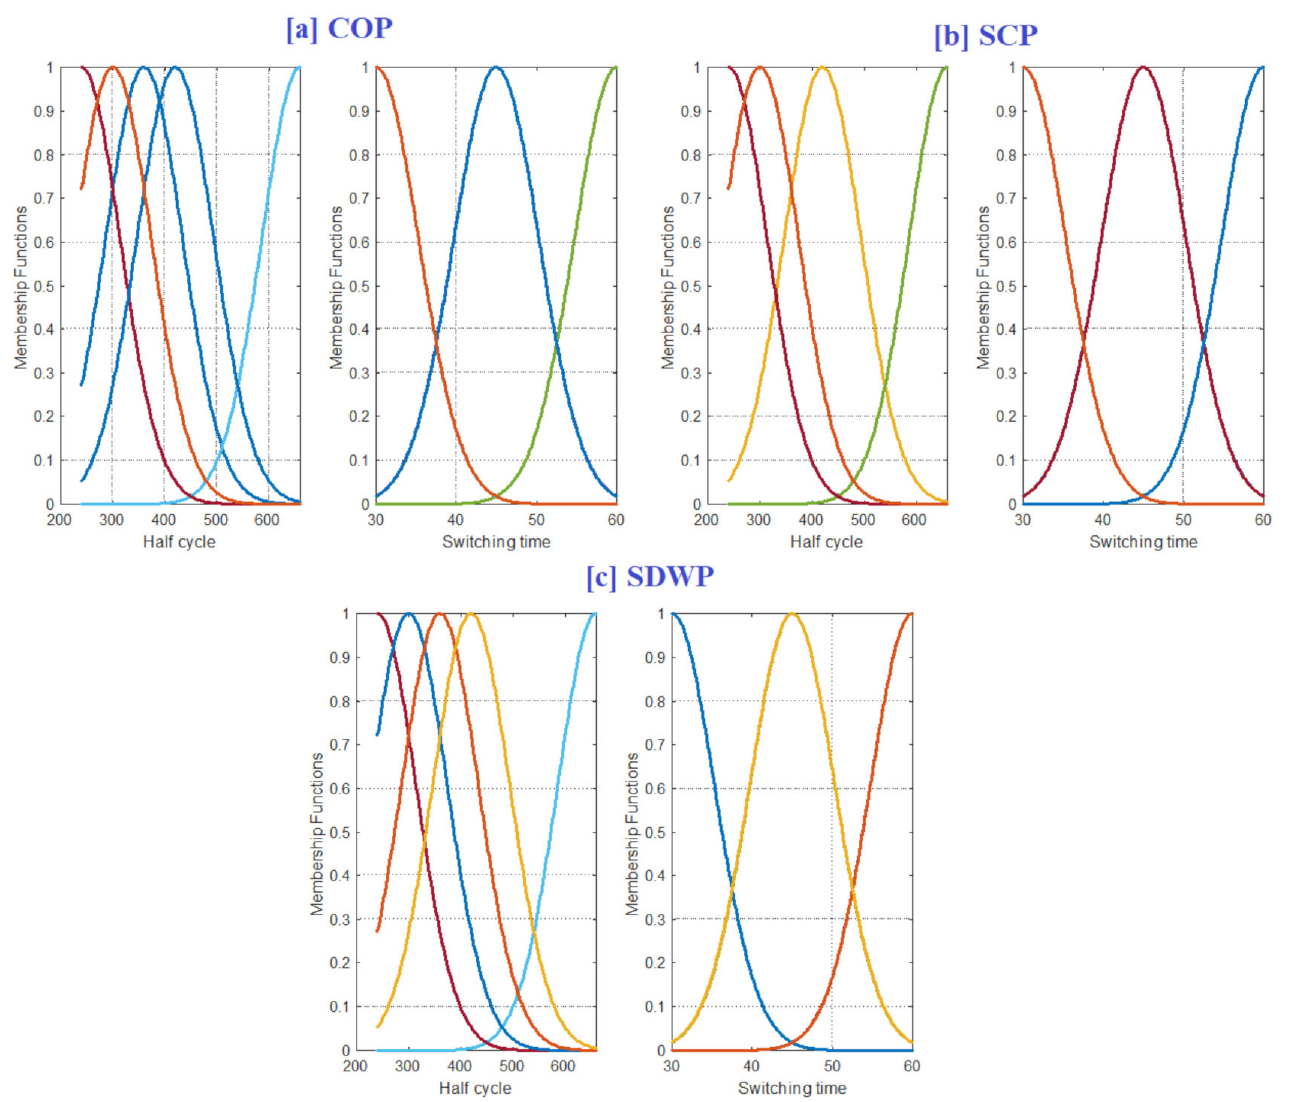
Figure 6. Inputs membership functions of the fuzzy system ( a ) COP; ( b ) SCP, and ( c ) SDWP. A significant measure to assess the model’s prediction precision is to plot these pre- dictions versus their corresponding targets. Consequently, Figure 7 presents the accuracy plots of COP, SCP, and SDWP models. Considering Figure 7, it is clear that for COP, SCP, and SDWP models, the training and the testing predictions are distributed closer to the one hundred percent accuracy line that matches with the obtained high values of the R 2